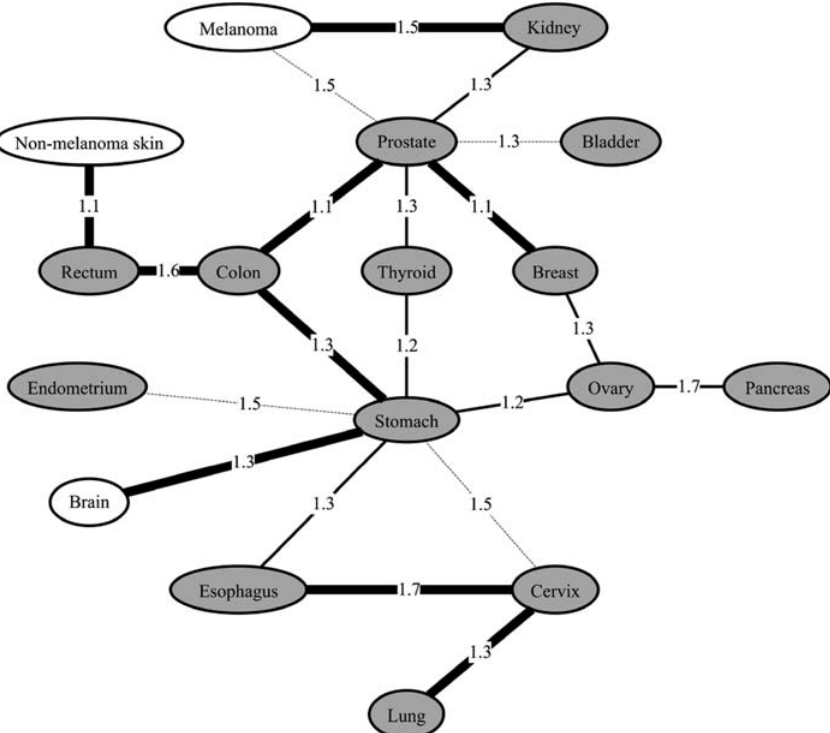
Figure 1. A Schematic Representation of Cancer Pairs Demonstrating Significant Familial